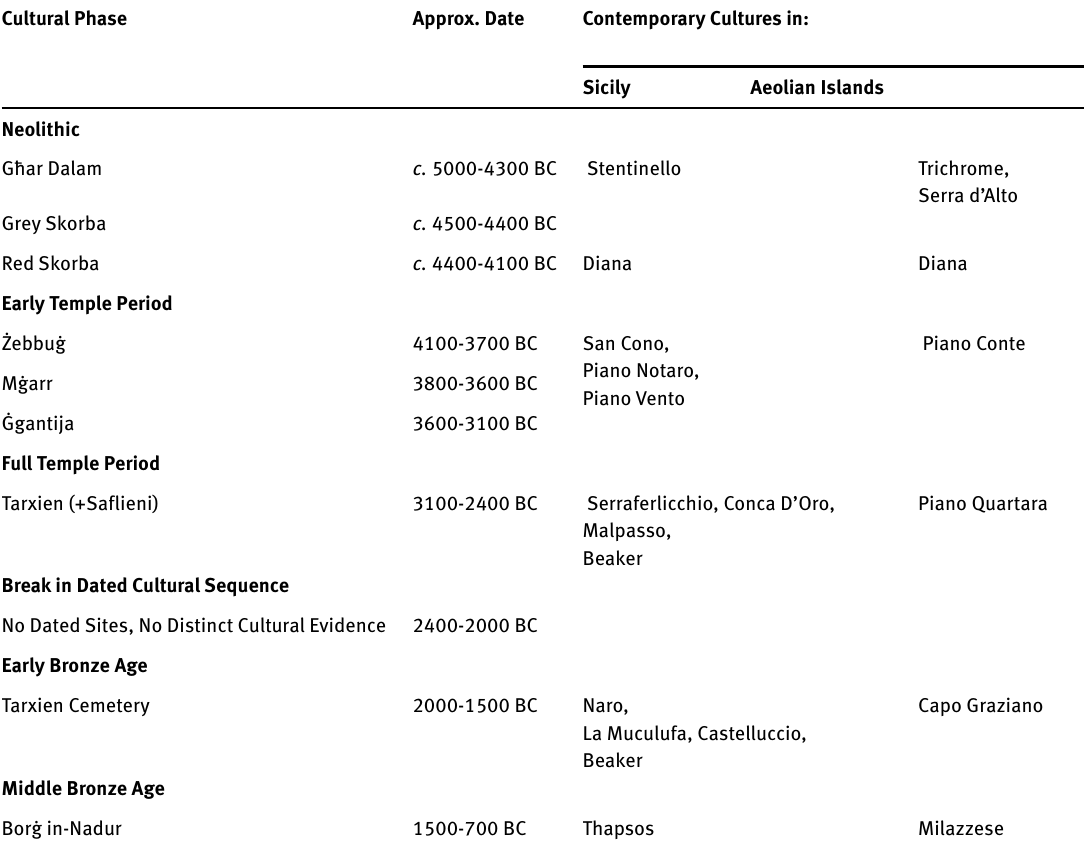
Table 1. Malta’s prehistoric chronology (adapted from Malone et al.